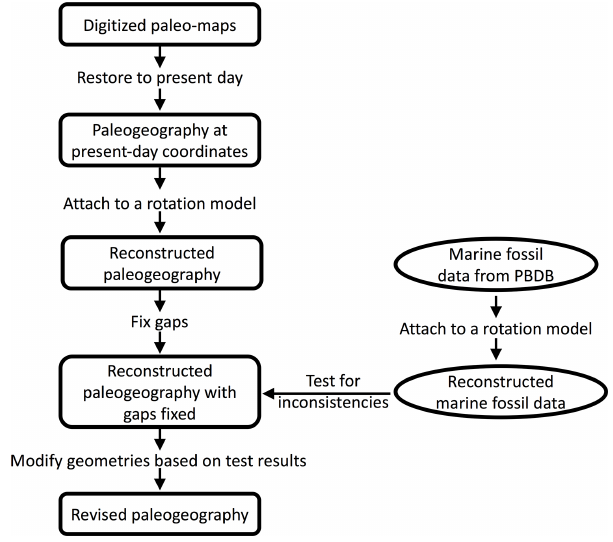
Figure 2. Workflow used to transfer a set of paleogeographic ge- ometries from one reconstruction to another, followed by revision using paleoenvironmental information indicated by marine fossil collections from the Paleobiology Database